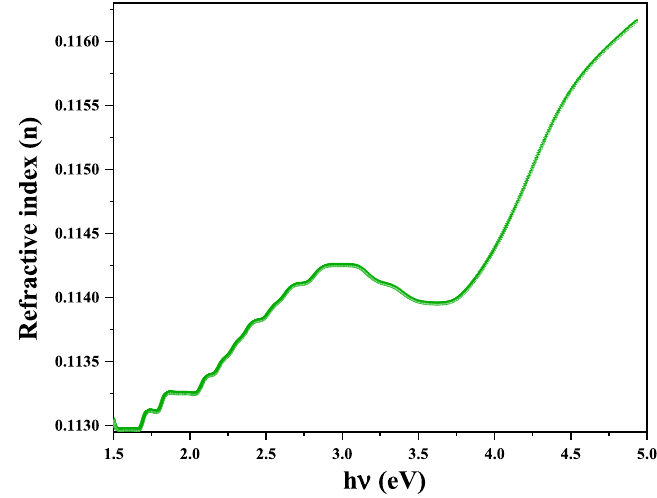
Figure 10. Plot of refractive index as function energy of AgO/Ag NPs.